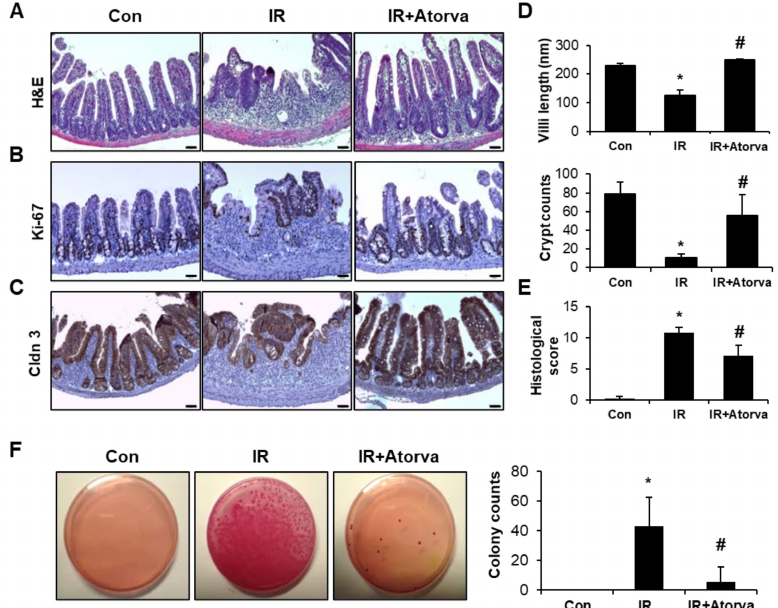
Figure 5. Atorvastatin mitigates radiation-induced intestinal damage in a mouse model. ( A ) Hema- toxylin and eosin (H&E) staining; immunostaining for ( B ) Ki-67 and ( C ) Claudin 3 (Cldn3); and ( D ) quantification of villi length and crypts in ileum tissues harvested from control (Con), irradiated (IR), and atorvastatin (Atorva)-treated IR (IR + Atorva) mice 6 days after the local application of 13.5 Gy of irradiation. Scale bars represent 50 µ m. ( E ) Histological scoring was assigned based on the degree of epithelial architecture maintenance, crypt damage, vascular enlargement, and infiltration of inflammatory cells in the lamina propria (0 = none, 1 = mild, 2 = moderate, 3 = high) of the ileum of Con, IR, and IR + Atorva groups. ( F ) The number of bacterial colonies from mesenteric lymph node tissue of Con, IR, and IR + Atorva groups. Data are presented as the mean ± standard deviation of the mean; n = 5 mice per group. * p < 0.05 compared to the Con group; # p < 0.05 compared to the IR